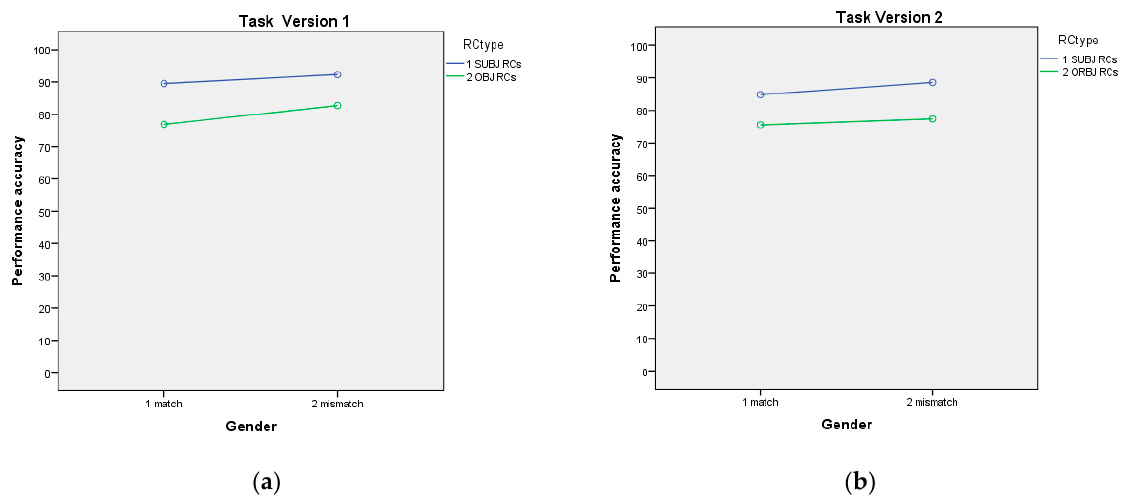
Figure 3. ( a ): Task 1 performance on SUBJ and OBJ RC, gender match and mismatch condition, ( b ): Task 2 performance on SUBJ and OBJ RC, gender match and mismatch condition.